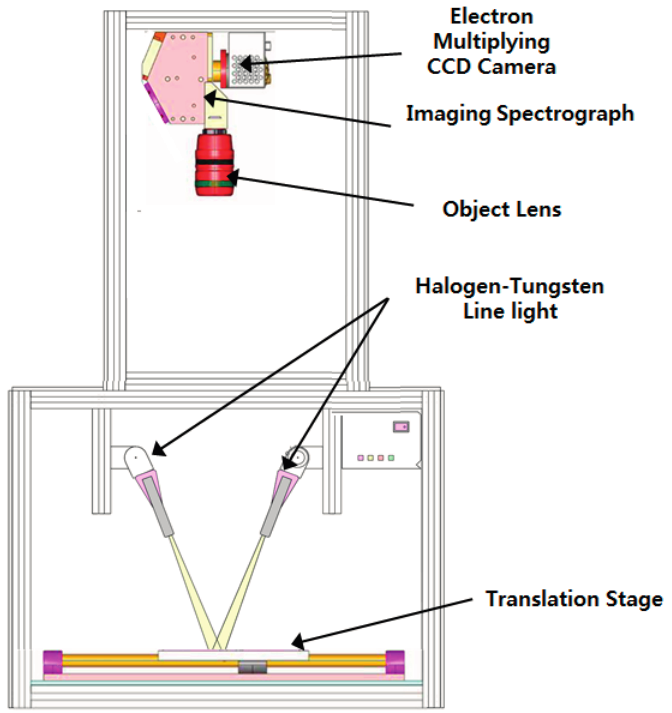
Figure 1. Schematic representation of the hyperspectral reflectance imaging